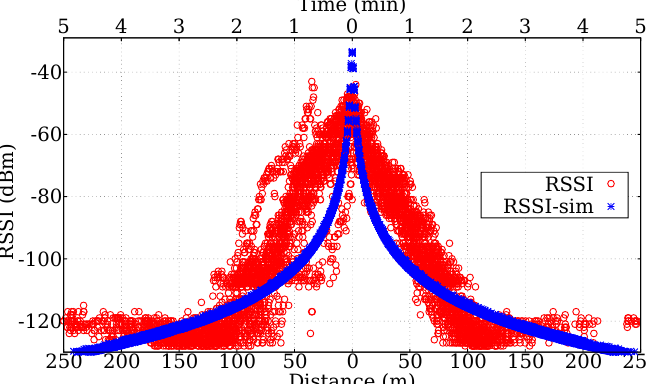
Figure 16. Received Signal Strength Indicator (RSSI) vs. distance—50m/min—simulated vs.